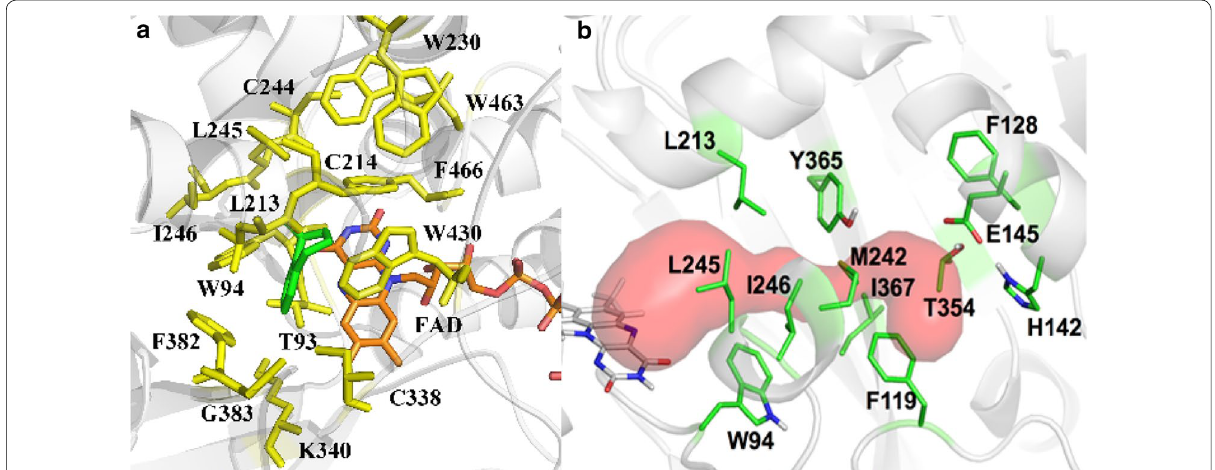
Fig. 6 MAO-N residues chosen for saturation mutagenesis, marked in the homology model, which was built using the crystal structure of MAO-N-D3 (PDB: 2VVL). A: Active site mutation sites (yellow), selected on the basis of induced fit docking of amine 19 (green). B: Residues surrounding the substrate access tunnel (red) likewise chosen for mutagenesis (shown in green)